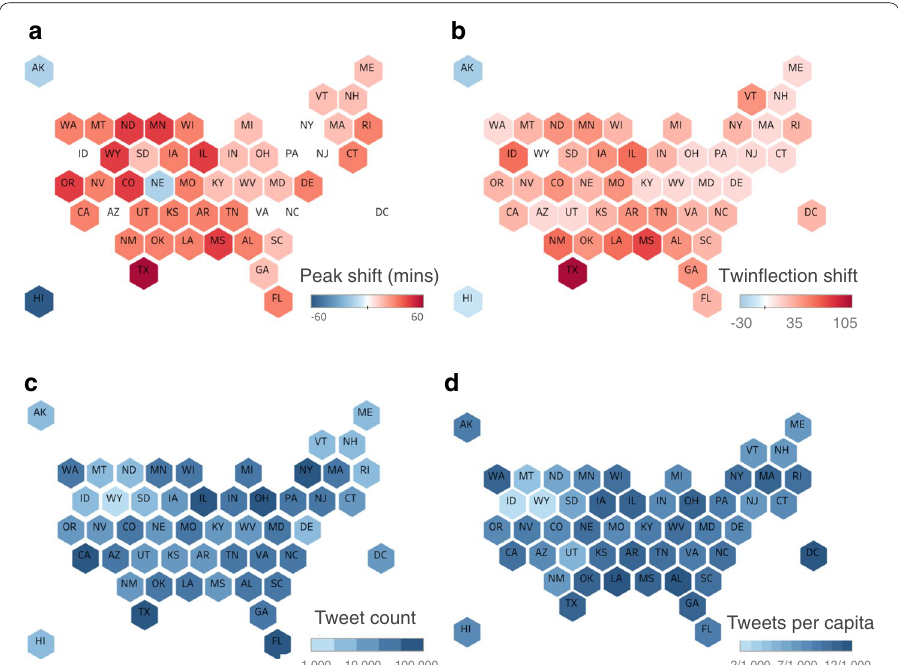
Fig. 4 The magnitude of Twitter behavioral shift following a Spring Forward event, averaged for the 4 years from 2011 to 2014. a Shift measured using behavioral curve peaks, the difference between the pair of maps in Fig. 3 (bottom minus top). Texas is estimated to have experienced the greatest time shift. The effect of Spring Forward is more pronounced in the South, and center of the country. Alaska, Nebraska, and Hawaii have negative shifts. b The same map, but with measurements calculated using twinflection shift instead. The states most affected are Texas and Mississippi, where the shift was 105 and 75 min respectively. Hawaii and Alaska are estimated to have negative shifts (15, and 30 min respectively). Twinflection shift produces similar spatial results to peak shift, with greater shift estimates. c The number of tweets posted from each state in the period after Spring Forward. California and Texas both contributed over 200,000 tweets, while Alaska, Hawaii, Idaho, Wyoming, Montana, North Dakota, South Dakota, Wyoming, Delaware, New Hampshire, Maine and Vermont each produced less than 10,000 tweets. (d) The density of data used to establish the experimental pattern of behavior, as measured by tweets per capita. This measurement reflects the ability of the data to capture the behavior of the tweeting population of each state. While Idaho, Wyoming, Montana, Utah and South Dakota have relatively little data compared to their populations, the remaining states have similar data density, with somewhere between five and eleven tweets per thousand residents, with the exception of the District of Columbia which has 35. Note: both panels (c) and (d) use logarithmically spaced